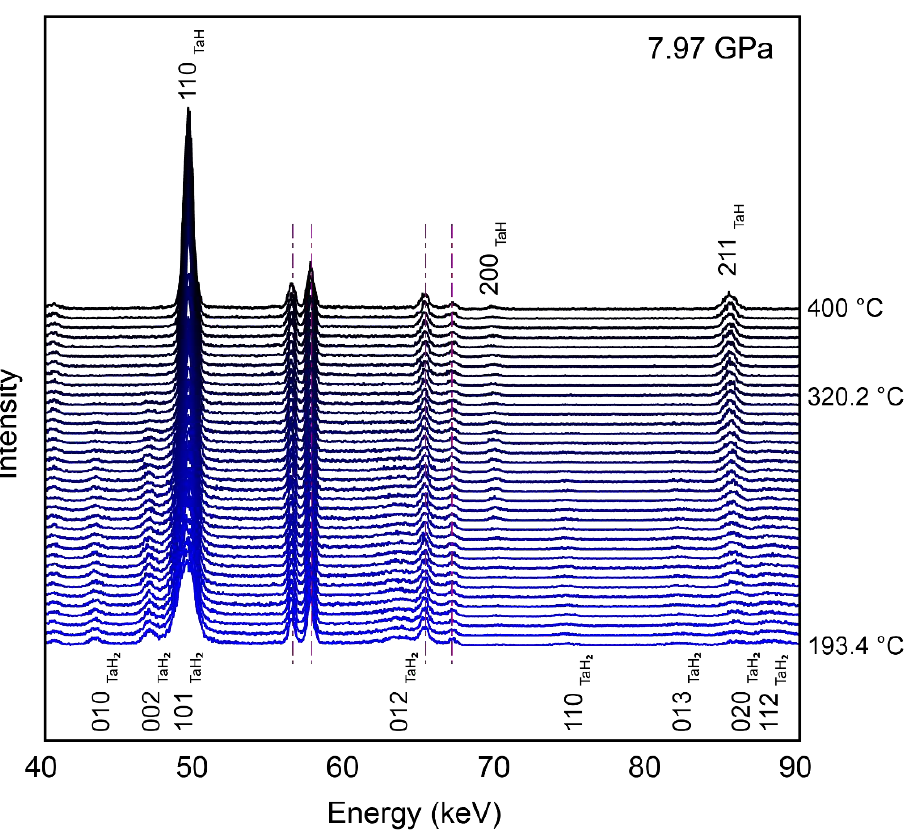
Figure 2. Series of in situ synchrotron radiation powder X-ray diffraction patterns of Ta and BN powder mixture at 7.97 GPa during cooling from 400 °C to 193.4 °C. The peaks on the dashed lines correspond to fluorescence from Ta.